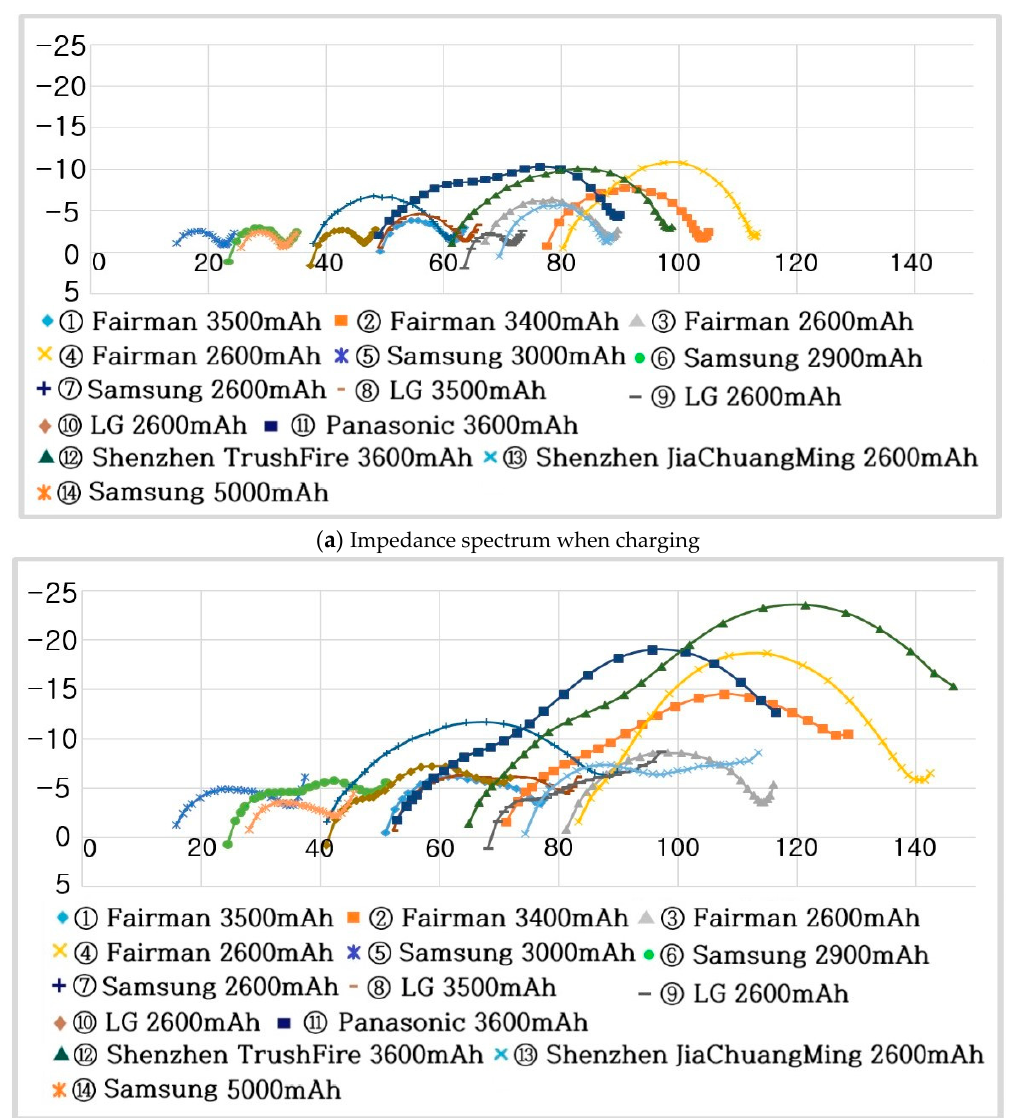
Figure 21. Impedance spectrum of 21700-type Li-ion Batteries (built-in protection device).